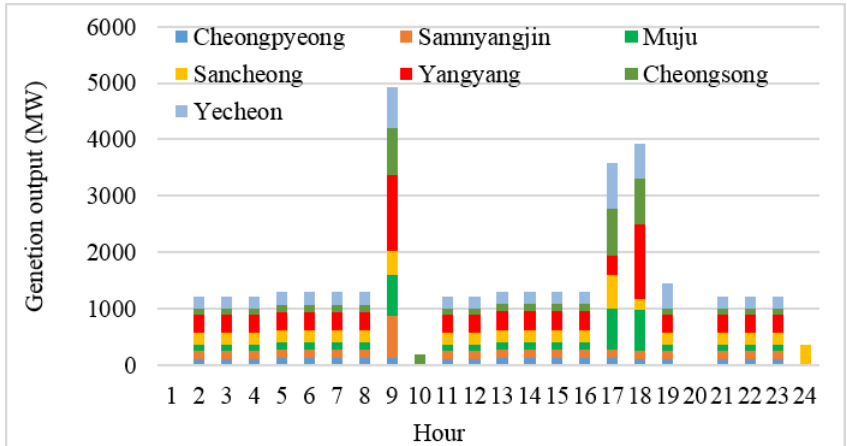
Figure 9. RSP t on the peak-load day in 2029.